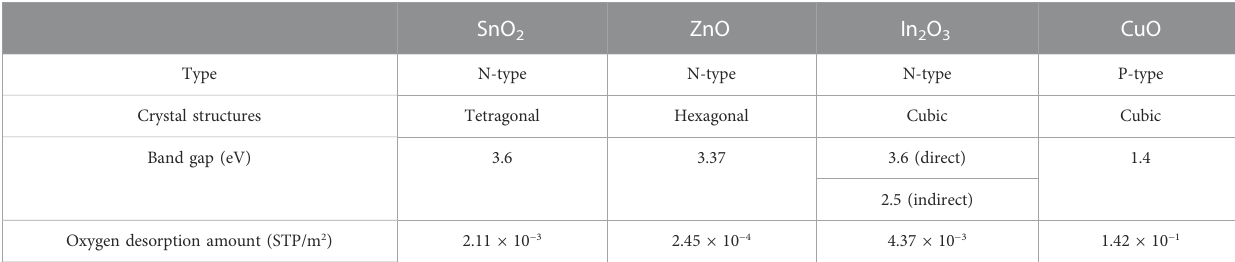
TABLE 1 The physical and chemical properties of semiconductor metal oxide (Iwamoto et al., 1978; Zhai et al.,